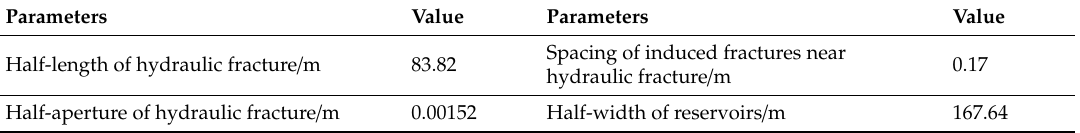
Figure 3. The flow rate of multi-fractured horizontal wells in shale gas reservoirs . Figure 4 shows the distribution of gas saturation in inorganic matter at 1 day of production. It can be seen from the figure that the USRV region had the same gas saturation as the initial gas saturation because it did not consider the water phase migration, and did not change with production. The closer the region to the hydraulic fracture, the lower the gas saturation and the higher the relative water saturation. The variation of gas saturation in inorganic matter in the ESRV region with production time was analyzed. The results are shown in Figure 5. It can be seen from the figure that as the production time increased, the gas saturation in the inorganic matter of the ESRV region